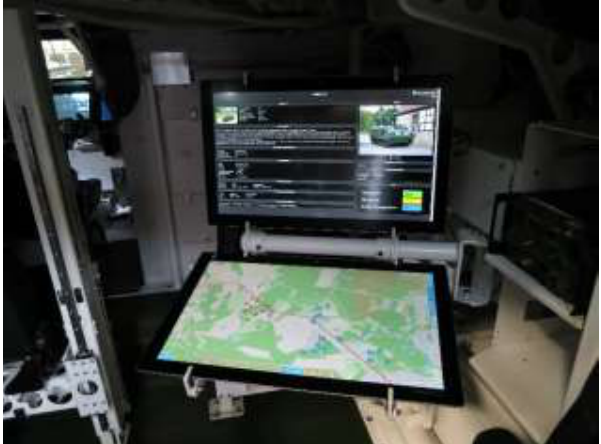
Figure 2: COP example in an APC PMMC G5 from FFG Flensburg, Germany.